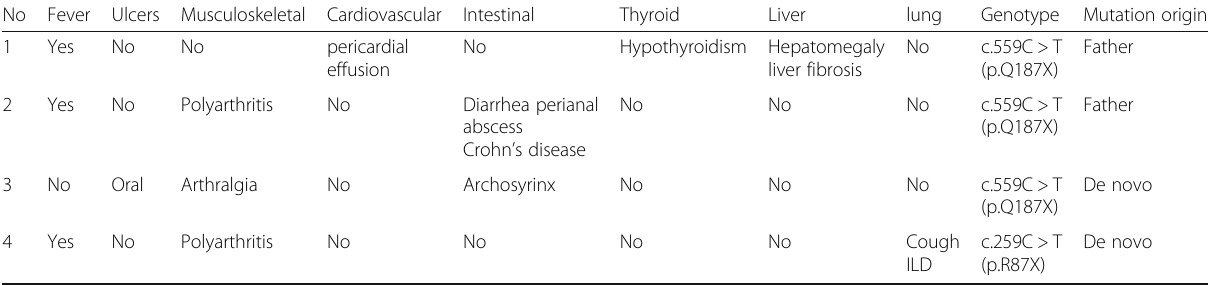
Table 2 Clinical features of patients with TNFAIP3 mutation No Fever Ulcers Musculoskeletal Cardiovascular